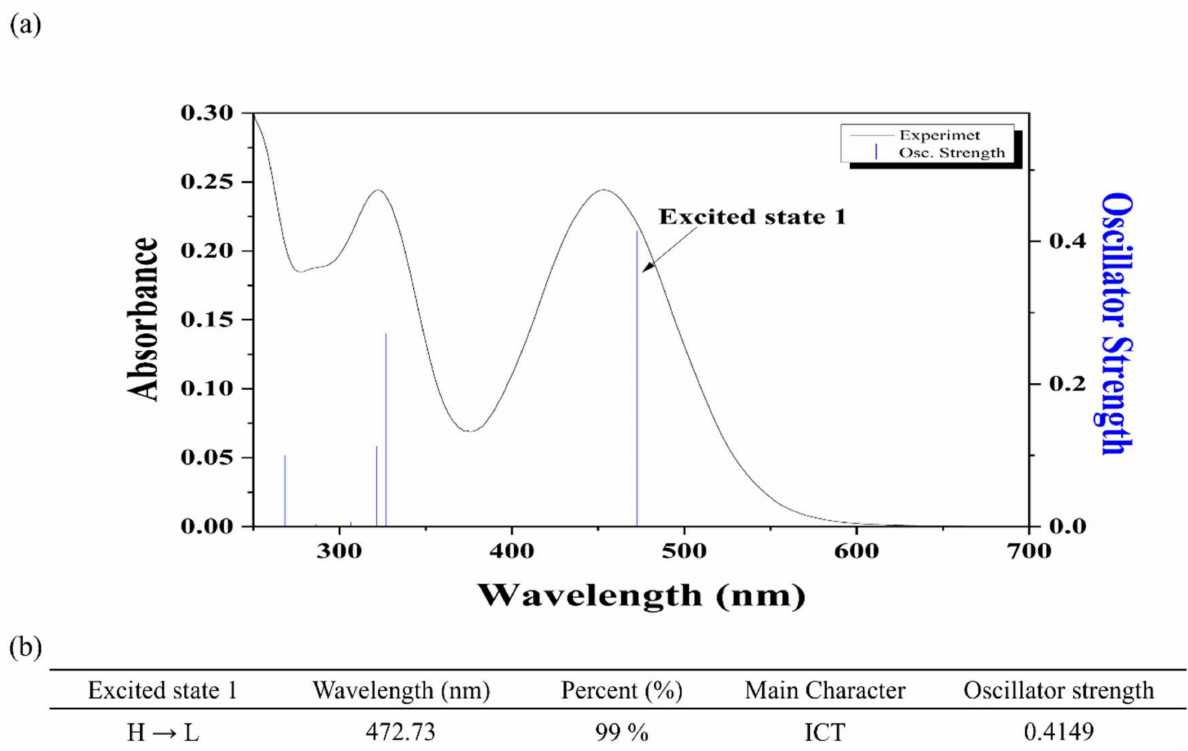
Figure 11. ( a ) The experimental UV-vis and theoretical excitation energies of DPP . ( b ) The significant electronic transition energies and MO contributions for DPP (H = HOMO and L = LUMO).